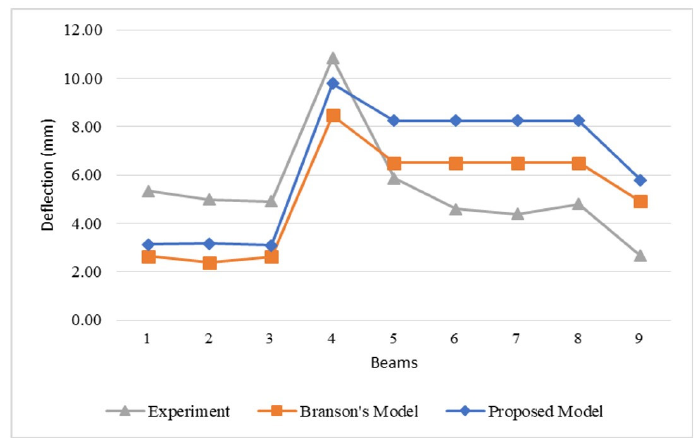
Figure 11. Beams with reinforcement rate from 1 to 2%.